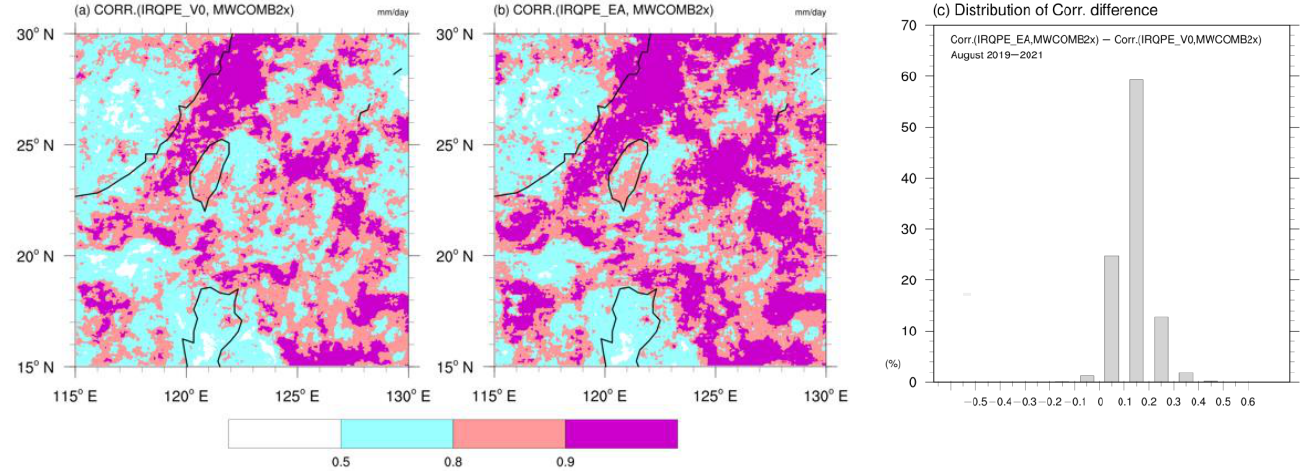
Figure 10. Point-to-point correlation between IRQPE and MWCOMB2x from data during August 2019 – 2021 on a spatial resolution of 0.05° lat/lon. ( a ) IRQPE_V0. ( b ) IRQPE_EA. ( c ) Frequency dis- tribution of the grid points from the difference of the 2 correlation maps in ( a , b ).